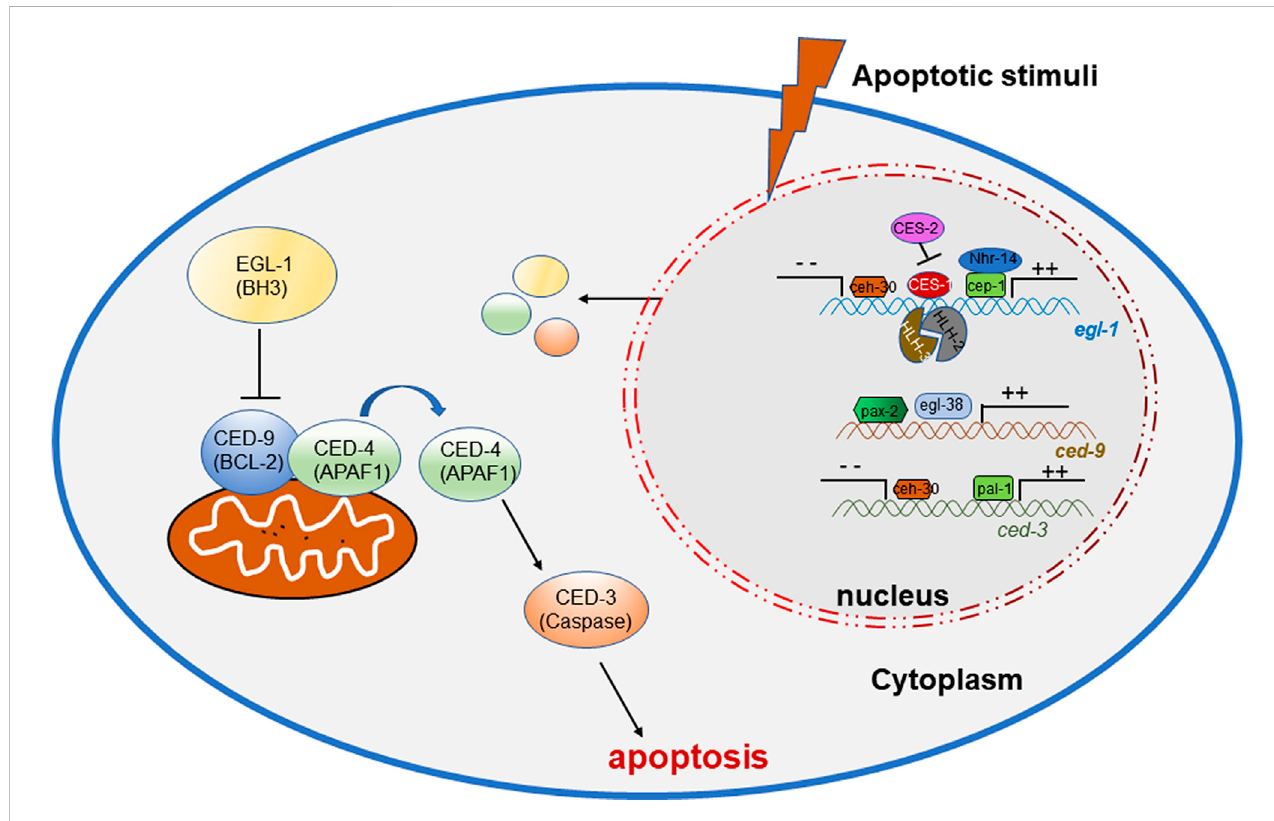
FIGURE 1 Transcription factors regulating the onset of apoptosis in C. elegans